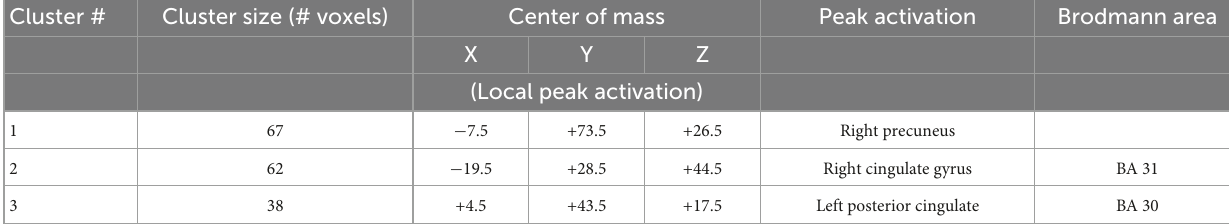
TABLE 5 Regions with significant sex*group interaction effect in all